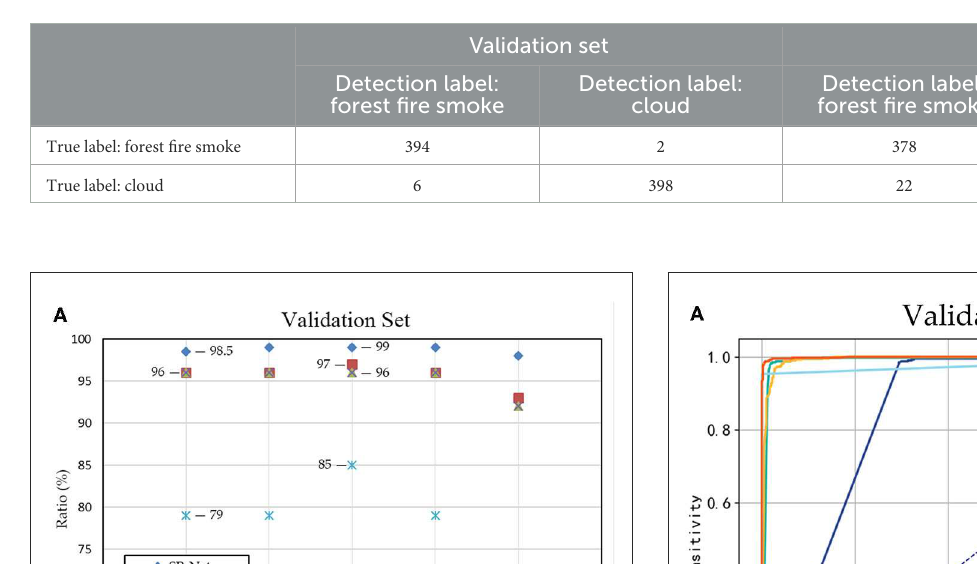
TABLE 5 Confusion matrix of the SR-Net model in the test and validation sets.